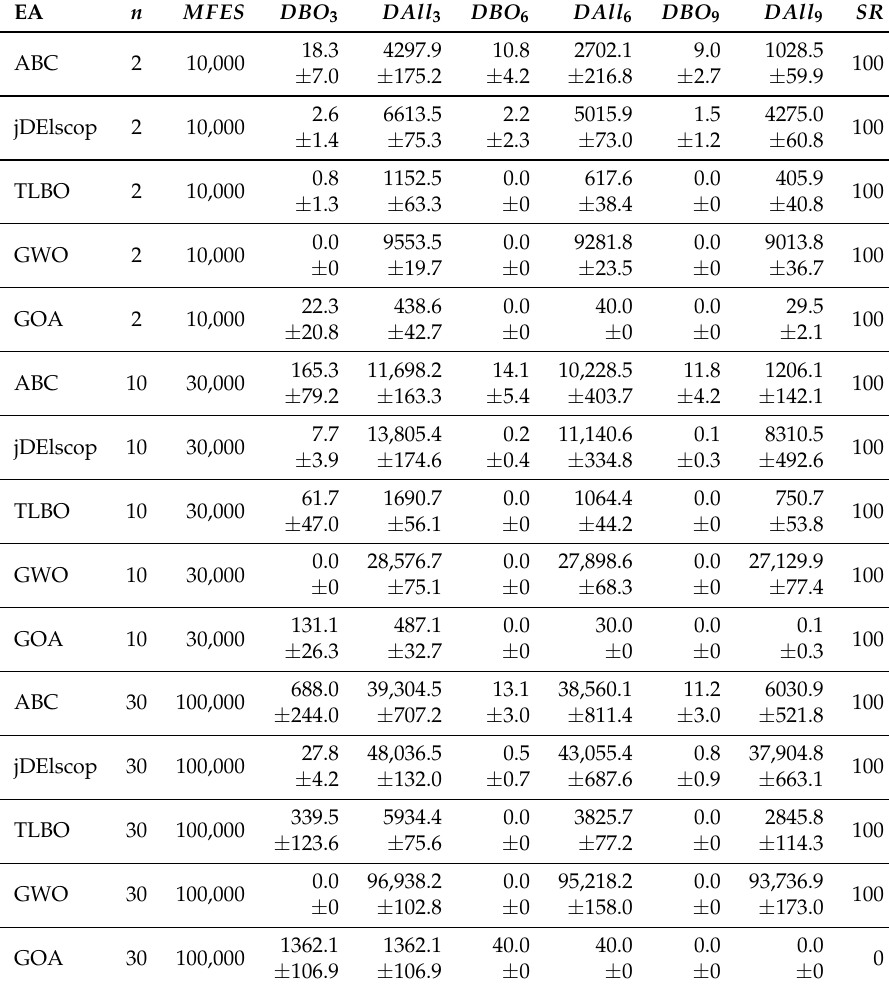
Figure 3. Fitness landscape of a Sphere problem for n = 2. Table 4. Number of duplicate individuals’ evaluation for the Sphere problem. TLBO, Teaching-Learning Based Optimization; GWO, Gray Wolf Optimizer; GOA, Grasshopper Optimization